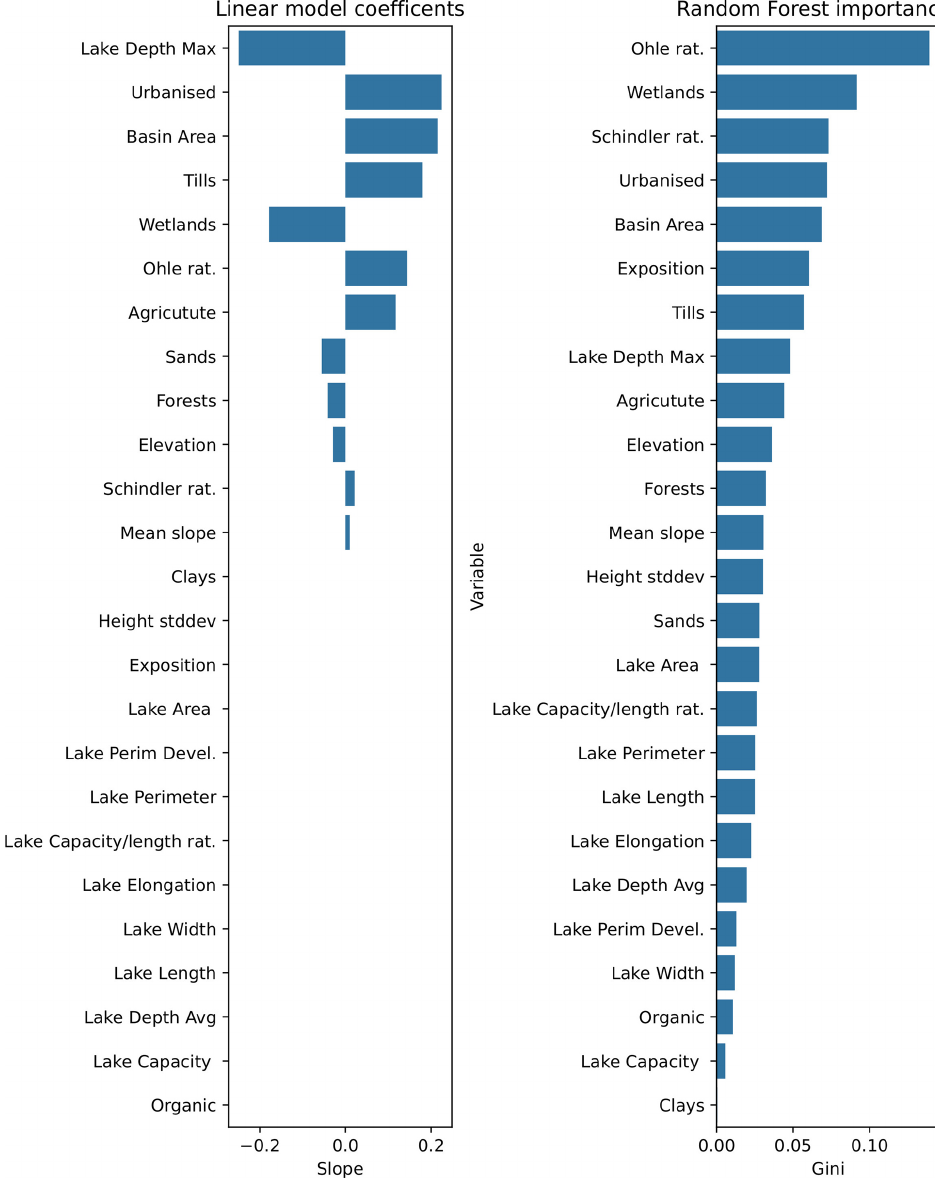
Fig. 10. The variable importance estimated using multiple linear regression (ElasticNet) and random forest. See text for